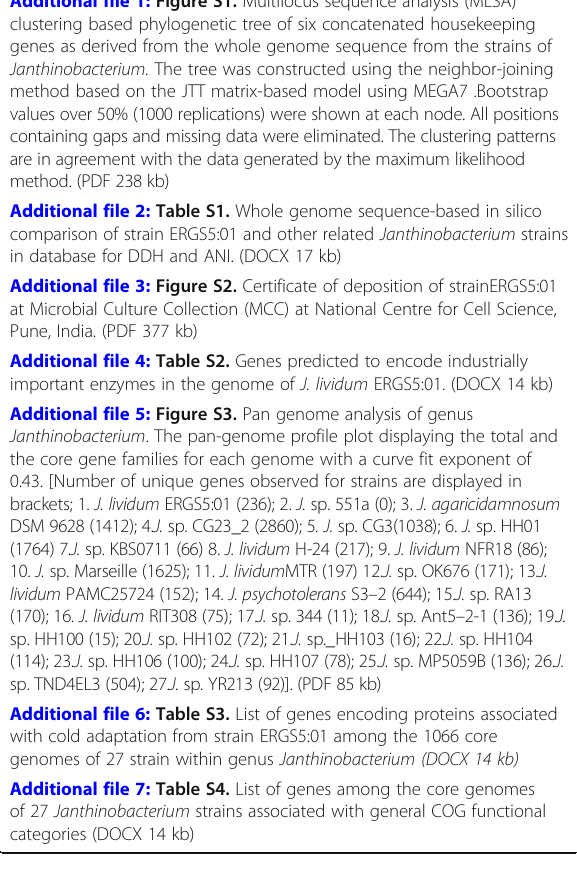
Additional file 6: Table S3. List of genes encoding proteins associated with cold adaptation from strain ERGS5:01 among the 1066 core genomes of 27 strain within genus Janthinobacterium (DOCX 14 kb) Additional file 7: Table S4. List of genes among the core genomes of 27 Janthinobacterium strains associated with general COG functional categories (DOCX 14 kb) Abbreviations ABM: Antarctic Bacterial Medium; ANI: Average nucleotide identities; aroE : shikimate dehydrogenase; CSPs: Cold shock proteins; DDH: DNA-DNA hybridization; gmk : guanylate kinase; gyrB : DNA gyrase B subunit; IMG: Integrated Microbial Genomes; MCC: Microbial Culture